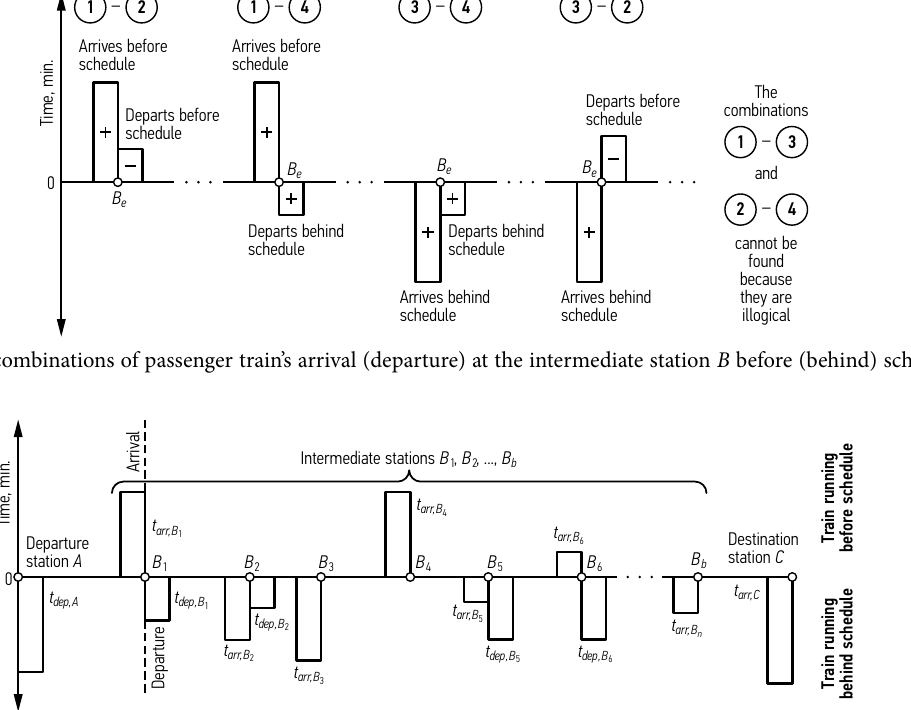
Fig. 4. Various available combinations of train’s keeping to schedule on the